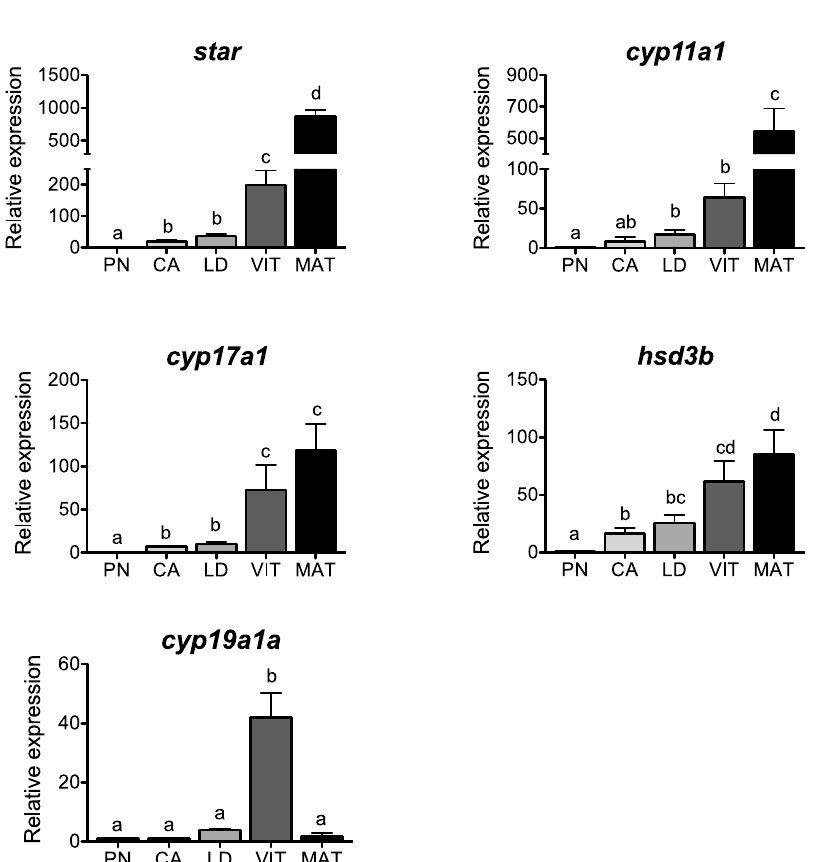
Fig. 2. Expression profiles of steroidogenesis-related genes during major stages of oogenesis in coho salmon. Messenger RNA levels were analyzed by qPCR and data were normalized to the geometric mean of four reference genes ( eef1a , ctsd , ctsz and actb ). PN, perinucleolus stage follicles; CA, cortical alveolus stage follicles; LD, lipid droplet stage follicles; VIT, mid-vitellogenic stage follicles; MAT, postvitellogenic/preovulatory stage follicles. Bars not sharing the same letter are significantly different (P , 0.05; n 5 4 fish/stage for PN-, CA-, LD-, and VIT-stages, n 5 3 fish for MAT-stage, mean ¡